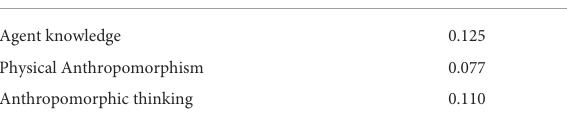
TABLE 7 Explanatory